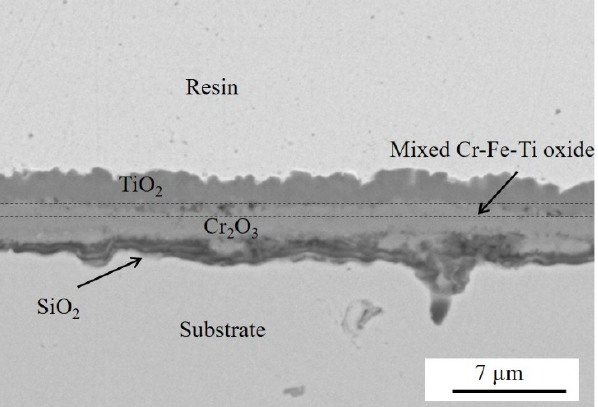
Figure 7. Magnification of the oxide layer formed in the case of the Ti-coated sample after 100 h aging at 800 °C under laboratory air.